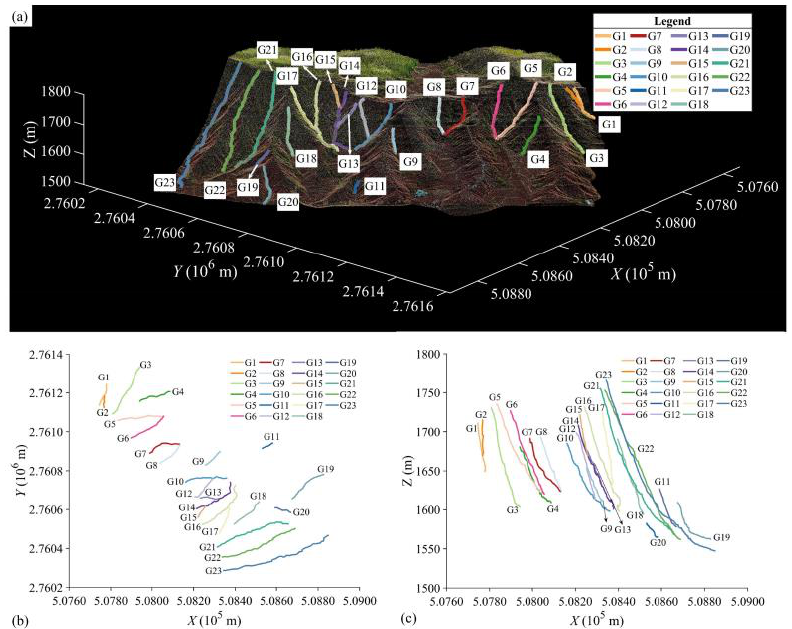
Figure 11. ( a ) The valley lines combined with point-cloud display, ( b ) the valley lines XY projection, and ( c ) the valley lines XZ projection. Table 4. Measurement results of valley lines’ morphological parameters.